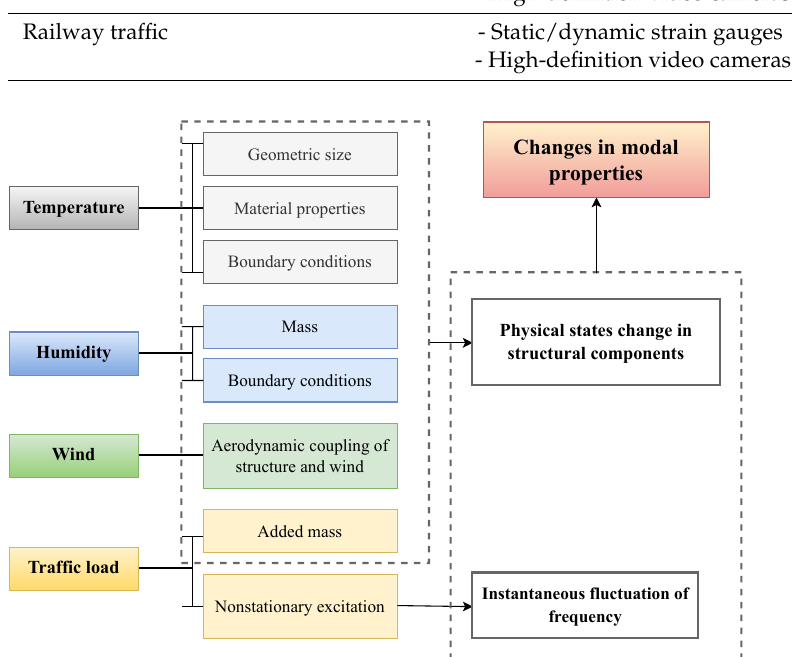
Figure 10. Influence mechanisms of EOCs on modal